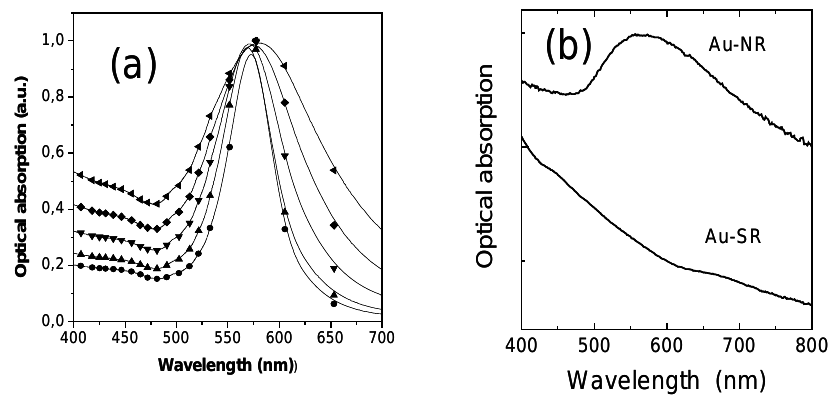
FIGURE 11 . (a) SPR from Au NPs with R = 2 nm ( (cid:101) ), 3 nm ( (cid:139) ), 5 nm ( (cid:100) ), 10 nm ( (cid:99) ), and 20 nm ( • ); (b) SPR from Au NP capped with a surfactant (top) and with thiols